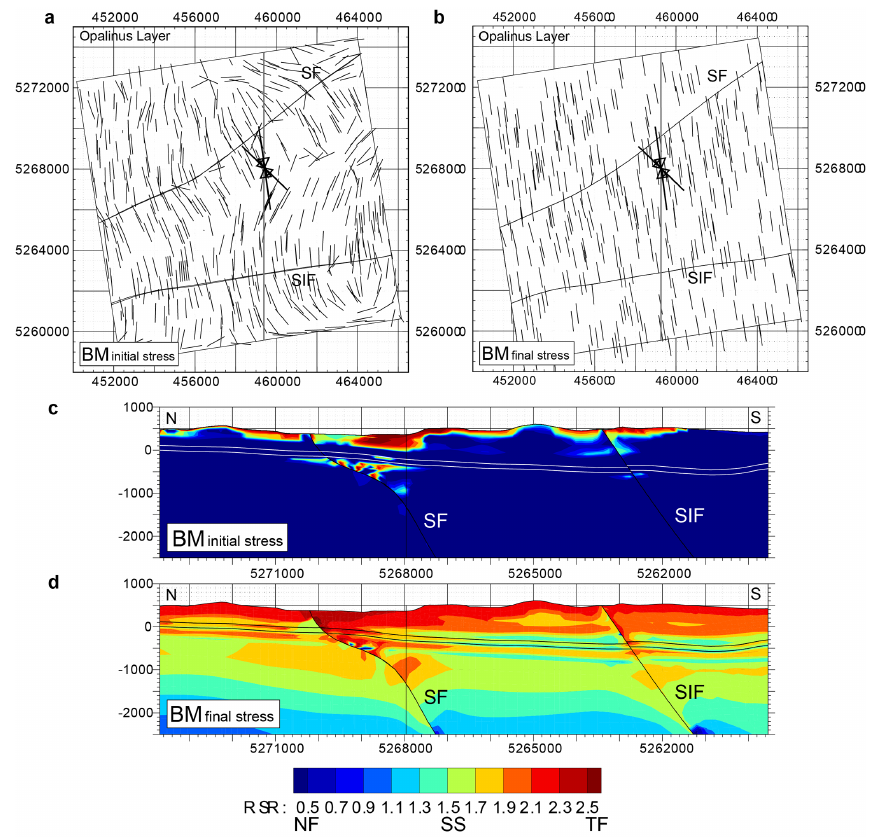
Figure 9. S H orientation and tectonic regime. (a) S H orientation at mid-depth of the Opalinus Clay layer for the initial stress field of model BM. Thin black lines show the modelled S H orientations and the two thick black lines the S H orientation derived at two depth levels at the Weiach well by Heidbach and Reinecker (2013) (see also Fig. 1). Thin north–south oriented line denotes location of the cross sections in (c) and (d) . (b) Same as (a) but for final stress field of model BM after applying tectonic loading. (c) Tectonic regime in terms of regime stress ratio (RSR) on a north–south cross section through the Weiach well for the initial stress field of model BM. The RSR provides a continuous range of the tectonic regime: NF, normal faulting; SS, strike-slip; TF, thrust faulting. (d) As in (c) , but for the final stress state of model BM. The south-dipping Opalinus Clay is indicated by thin black and white lines,